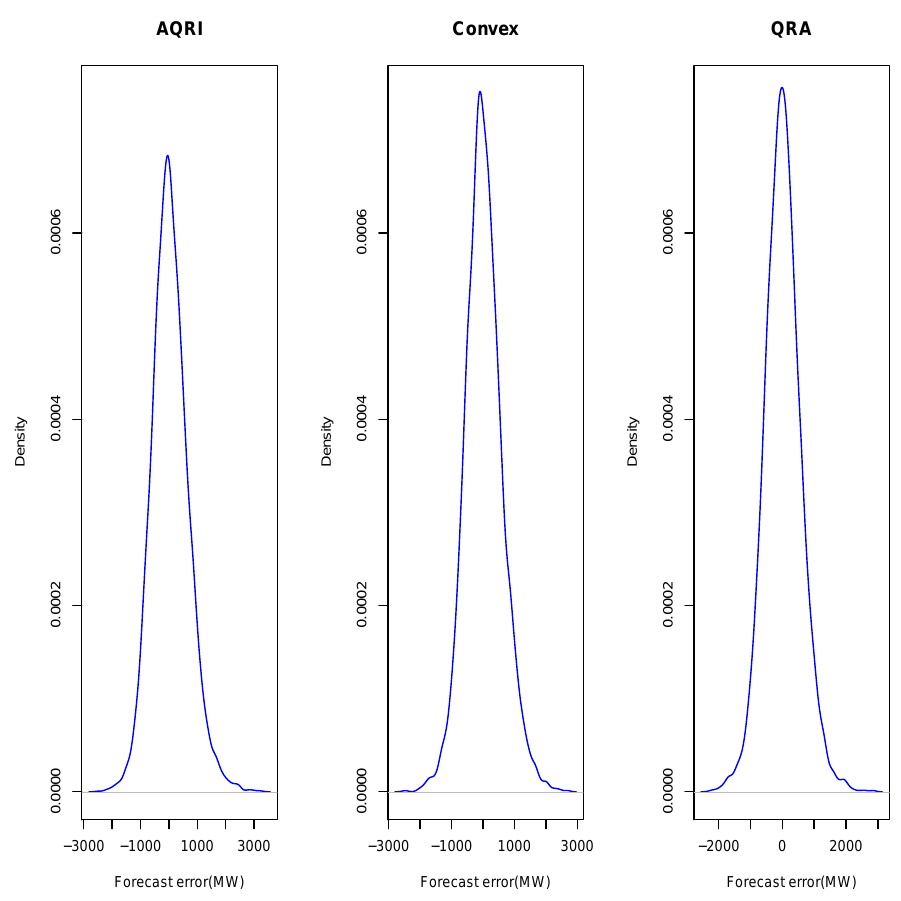
Figure 7. The error distribution of forecasting techniques for M4(AQRI), M5(convex) and M6(QRA).